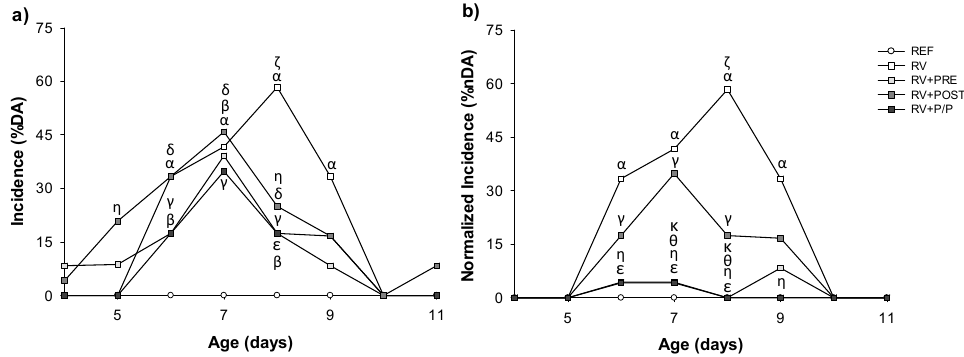
Figure 2. Incidence of RV infection expressed as percentage of diarrheic animals (% DA) by two approaches: non-normalized results ( a ) and normalized results ( b ) from day 4 to day 11 ( n = 24 animals/group). Statistical significance: α p < 0.05 RV vs. REF, β RV + PRE vs. REF, γ RV + POST vs. REF, δ RV + P/P vs. REF, ε RV + PRE vs. RV, ζ RV + POST vs. RV, η RV + P/P vs. RV, θ RV + POST vs. RV + PRE, ι RV + P/P vs. RV + PRE, and κ RV + P/P vs. RV + POST. REF: reference group; RV: rotavirus group; RV + PRE: rotavirus group supplemented with a mixture of scGOS/lcFOS; RV + POST: rota- virus group supplemented with Lactofidus TM ; RV + P/P: rotavirus group supplemented with the combination of both.